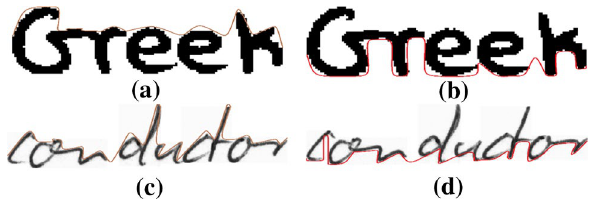
Fig. 10 a and b represent upper and lower Bezier curves of a word image from ICFHR 2014 H-KWS competition dataset [54] while c and d represent the same for a word taken from the IAM dataset